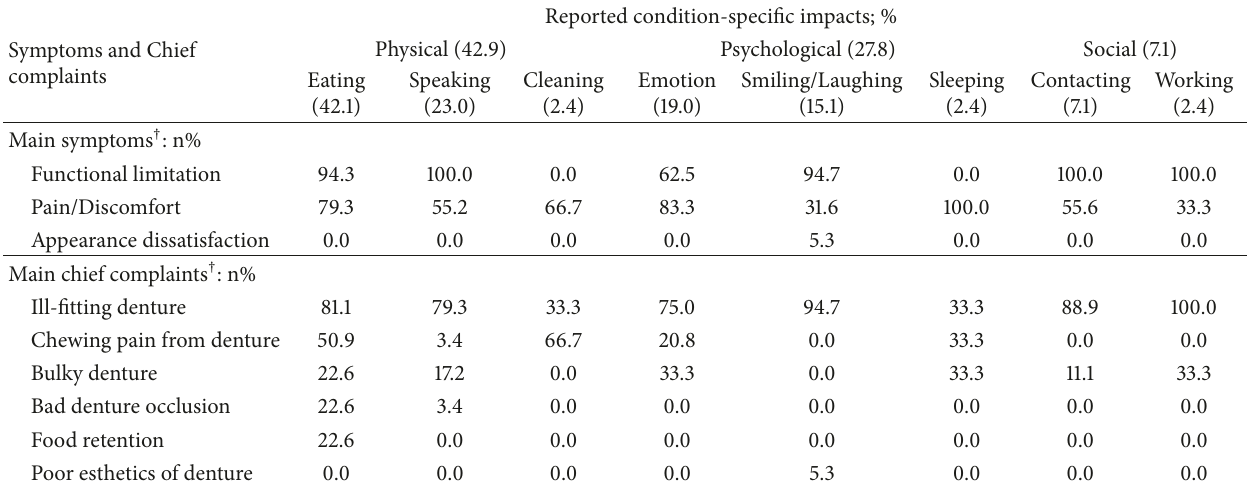
Table 2: Distribution of the participants with reported oral impacts according to main symptoms and chief